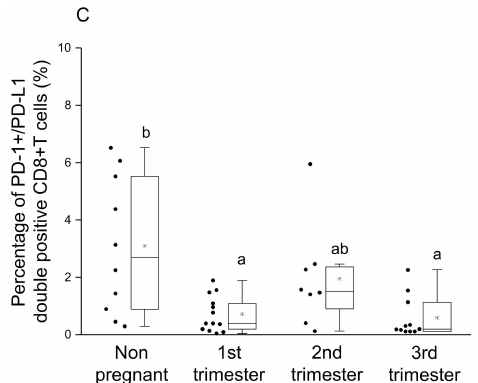
Figure 3. Percentage of PD-1 + immune cell subpopulations in PD-1 + cells and the percentage of PD-1 / PD-L1 double-positive CD8 + T cells throughout pregnancy and in nonpregnant women. The percentage of the PD-1 + CD8 + T cells ( A ) and PD-1 + NKT-like ( B ) cells in the PD-1 + cell population ( A ) and the percentage of PD-1 +/ PD-L1 double-positive CD8 + T cells ( C ) The solid bars represent medians of 10, 13, 10 and 12 samples, the boxes indicate the interquartile ranges, and the lines show the most extreme observations. Di ff erences were considered statistically significant for p -values ≤ 0.05. Variables with the same letter indicate no statistically significant di ff erence, while di ff erent letters indicate a statistically significant di ff erence.